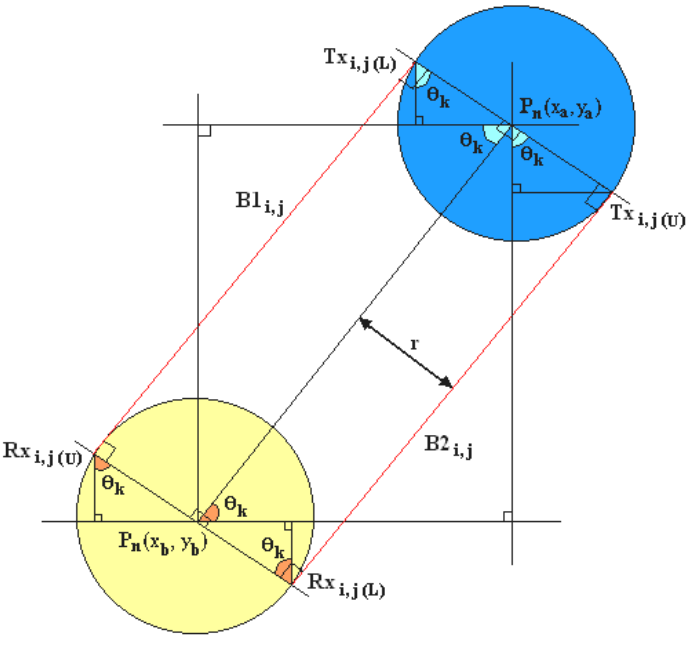
Figure 3. Tangent modelling of